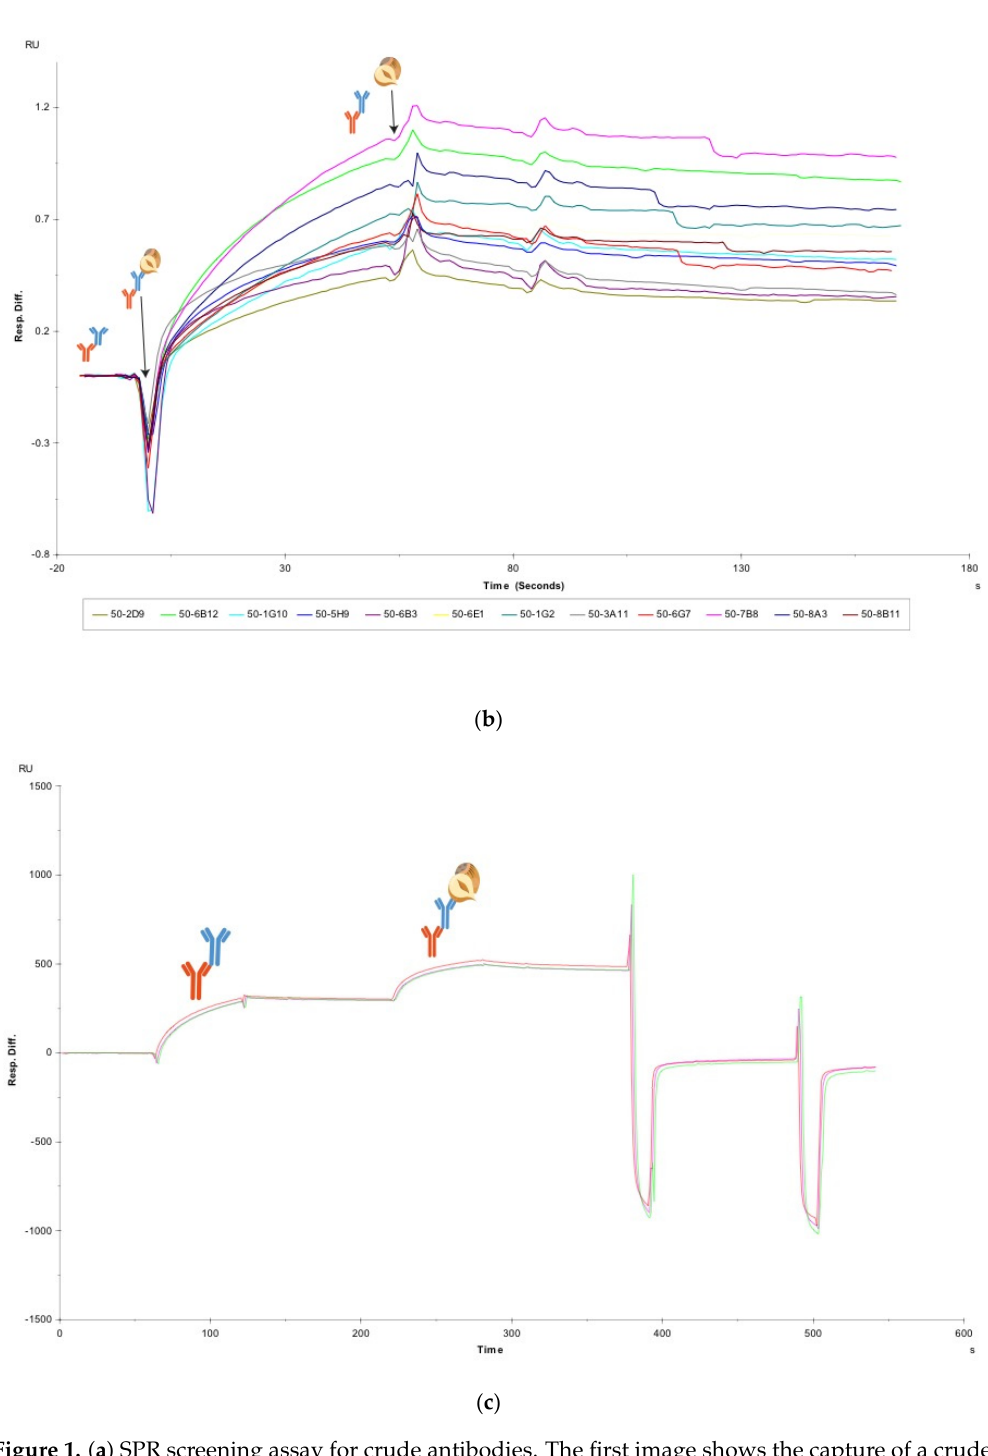
Figure 1. ( a ) SPR screening assay for crude antibodies. The first image shows the capture of a crude anti-hazelnut mAb (blue) via its FC region by the FC specific IgG (orange). The second image shows the binding of total hazelnut protein to the anti-hazelnut mAb. The third image displays the sandwich pairing of an anti-hazelnut mAb (blue) towards hazelnut and another anti-hazelnut mAb (blue). ( b ) Normalised SPR sensorgrams for 12 crude antibody preparations against 20 ppm hazelnut extract. The hazelnut injection is indicated by the first arrow, which is followed by the association of the crude antibodies towards hazelnut. The second arrow indicates the start of the hazelnut dissociation from the antibodies. ( c ) Full sensorgram of a crude antibody towards hazelnut in triplicate. The first curve shows the capture of the crude antibody via its FC region, the second curve the binding of hazelnut to that antibody and the following two spikes the